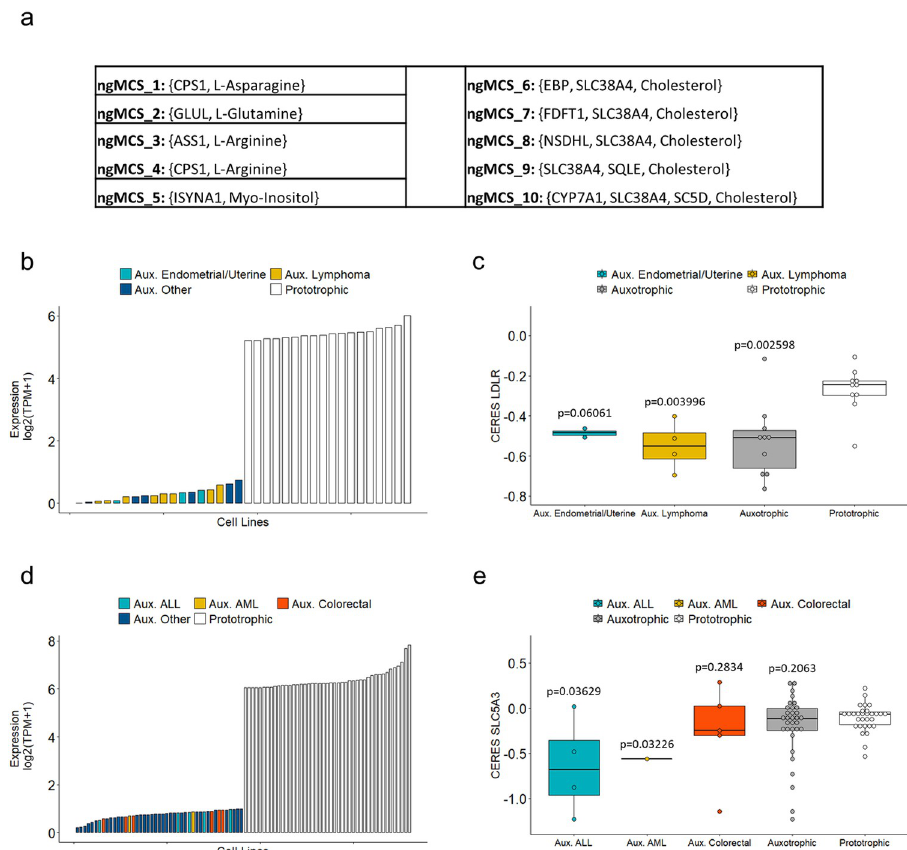
Fig 4. Extracellular nutrient dependences of in vitro cancer cell lines. a) Relevant ngMCSs involving L-Asparagine, L-Glutamine, L-Arginine, Myo-Inositol and Cholesterol. b) Expression levels of the most limiting gene in the ngMCSs associated with Cholesterol in 18 auxotrophic and 18 prototrophic cell lines. Auxotrophic cell lines were defined as those where the most limiting gene has an expression level below 1 TPM. For comparison, we took the same number of prototrophic cell lines; c) CERES scores for LDLR in the cell lines shown in b). The more negative CERES scores are, the more cellular proliferation will be decreased; d) Expression levels of the most limiting gene in the ngMCSs associated with Myo-Inositol in 45 auxotrophic and 45 prototrophic cell lines. e) CERES scores for SLC5A3 in the cell lines shown in d). Abbreviations: ‘ALL’ and ‘AML’ refer to Acute Lymphoblastic Leukemia and Acute Myeloid Leukemia, respectively. In addition, ‘Aux.’ refers to auxotrophic cell lines, e . g . Aux. ALL refers to auxotrophic ALL cell lines. Note here that in panels (b)-(d) gene expression data was obtained from CCLE [9] and in panels (c)-(e) CERES scores were obtained from the DepMap platform [8]. The significance of the difference in LDLR and SLC5A3 CERES scores in the auxotrophic groups against the corresponding prototrophic group was assessed via a one-tailed Wilcoxon